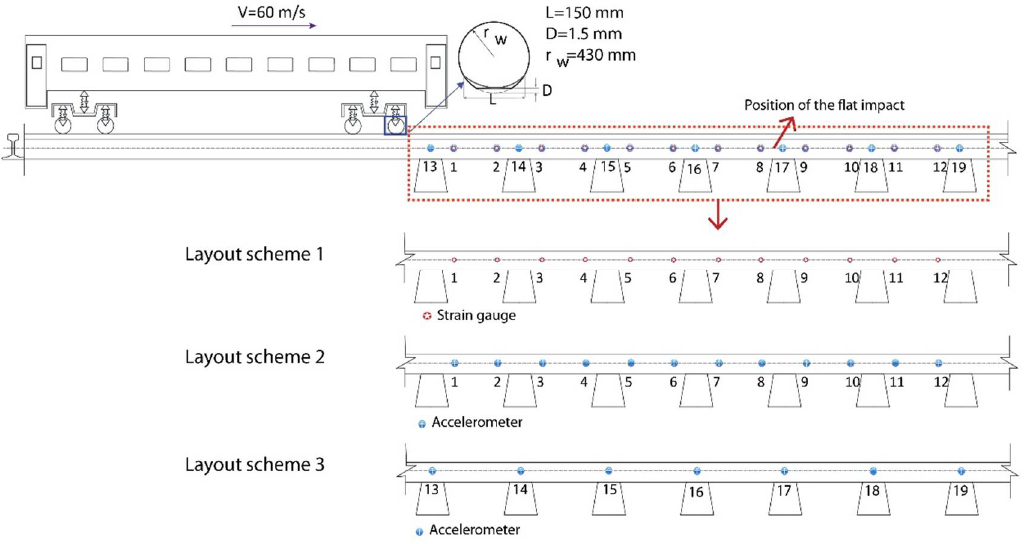
Figure 5. Schematic of a vehicle containing the damaged wheel.